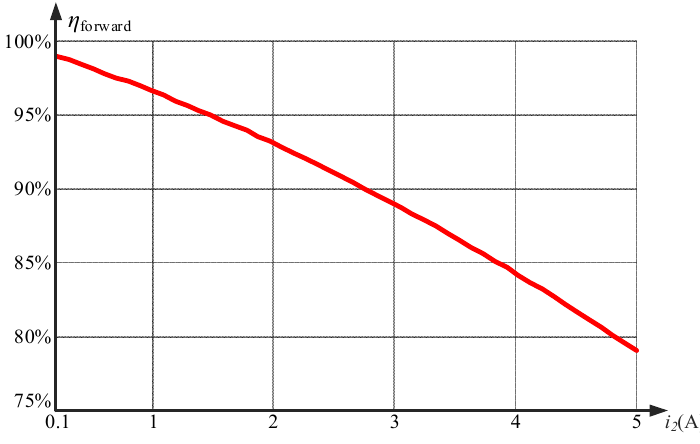
Figure 18. Efficiency estimation for the forward mode.